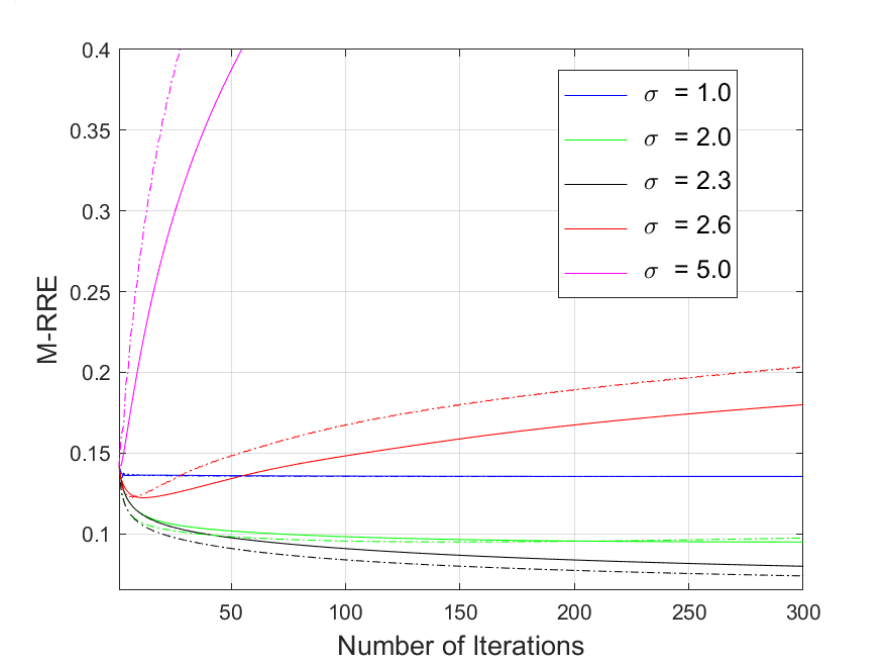
Figure 9. Mean relative reconstruction error (M-RRE) as a function of the number of iterations for different reconstruction kernels using standard (solid lines) and accelerated RL deconvolution (dashed